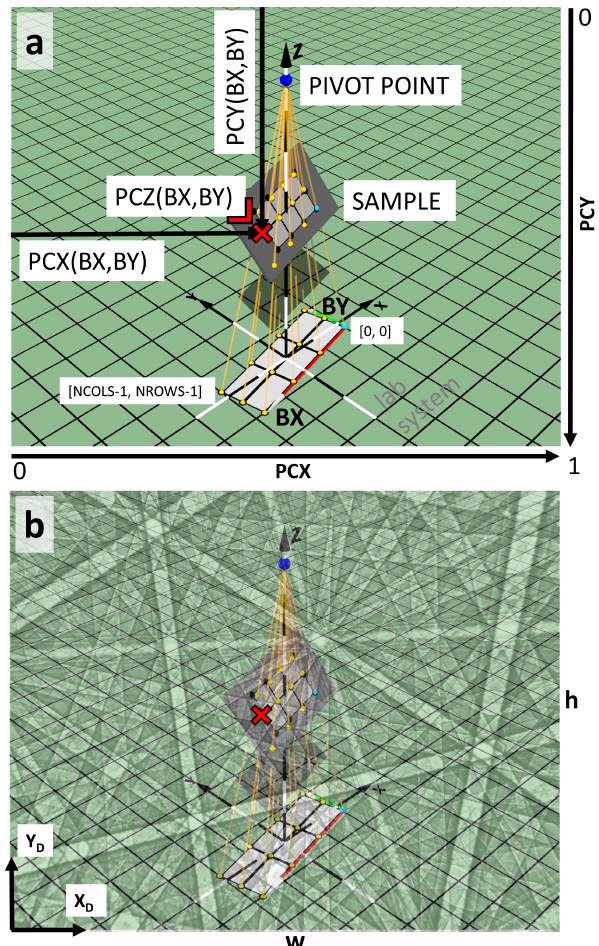
Figure 1. Illustration of the 3D geometry relevant to the EBSD projection center. ( a ) projection geometry of the SEM beam scanning the sample as seen from an EBSD detector screen plane in a general position. The scan pattern shows the combined effects of scan rotation and the sample tilt; ( b ) correspondingly simulated Kikuchi pattern with ( PCX , PCY , PCZ ) = ( 0.463,0.516,0.6 ) as a semi-transparent overlay on the screen plane. The projection center is at the position of the electron beam on the sample, PCZ units of the screen height behind the pattern, measured normal to the screen plane. The decreased visibility of the scan geometry in ( b ) is intended to remind the reader that the scan geometry is usually hidden by the detection screen with the Kikuchi diffraction